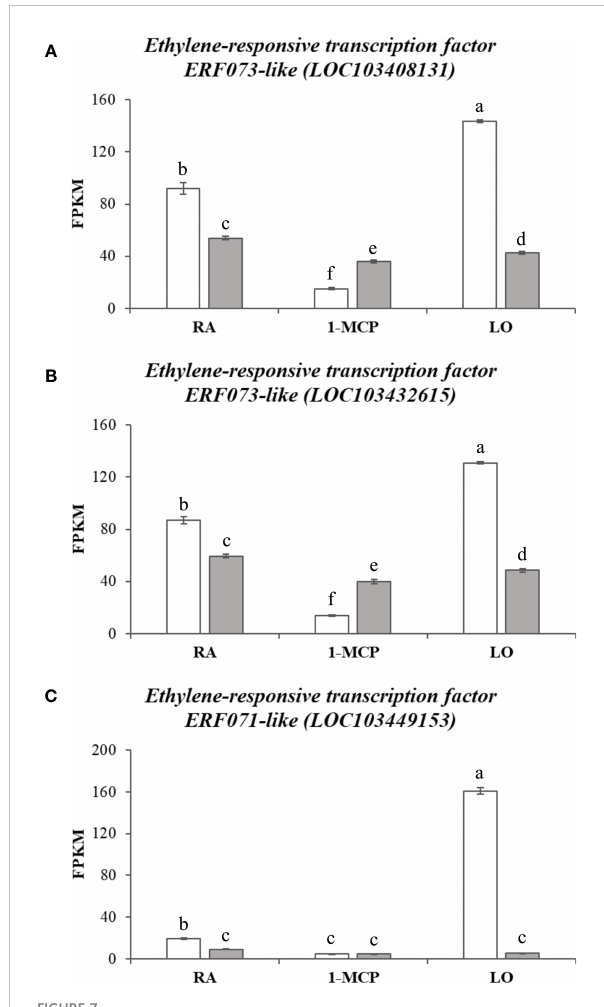
FIGURE 7 Expression level in ‘ Granny Smith ’ (white bar) and ‘ Ladina ’ (grey bar) apple cultivars of three Ethylene-responsive transcription factor (ERF-like) genes depicted in (A – C) , respectively. The error bars correspond to the standard deviation. RA, Regular Atmosphere; 1- MCP, Regular Atmosphere + 1-MCP treatment; LO, Low Oxygen condition. FPKM, fragments per kilobase of transcript per million fragments mapped. Different letters indicate difference statistically signi fi